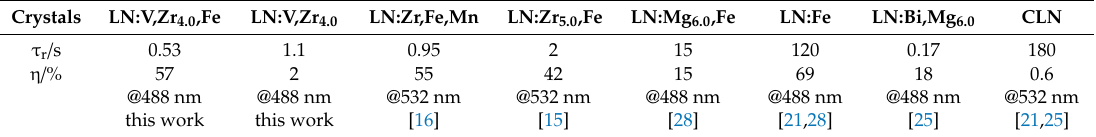
Table 2. The response times and diffraction efficiency of various co-doped and congruent LN crystals.